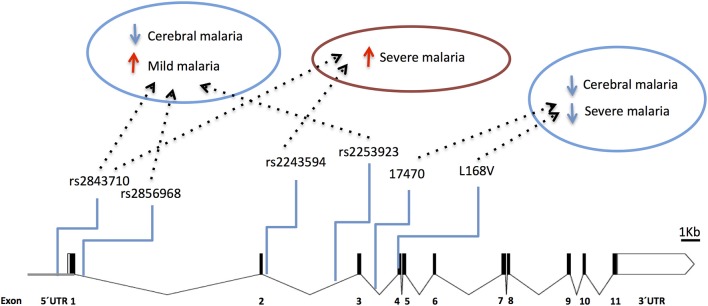
Genetic effects of IFNAR1 SNPs associated to clinical malaria. The scaled diagram of IFNAR1 exon-intron structure represents SNPs that have shown association with different malaria clinical outcomes (bar = 1 Kb). Experimental data suggest that detrimental IFNAR1 genetic effects (red arrows) could be attributed to alleles mediating decreased IFNAR1 signaling that impairs innate anti-parasite responses while beneficial effects (blue arrows) would be conferred by alleles that also decrease IFNAR1 signaling in the context of adaptive effector responses, and in particular deter cerebral immunopathology. For allele description and reported genetic effects (Supplementary Table 1).